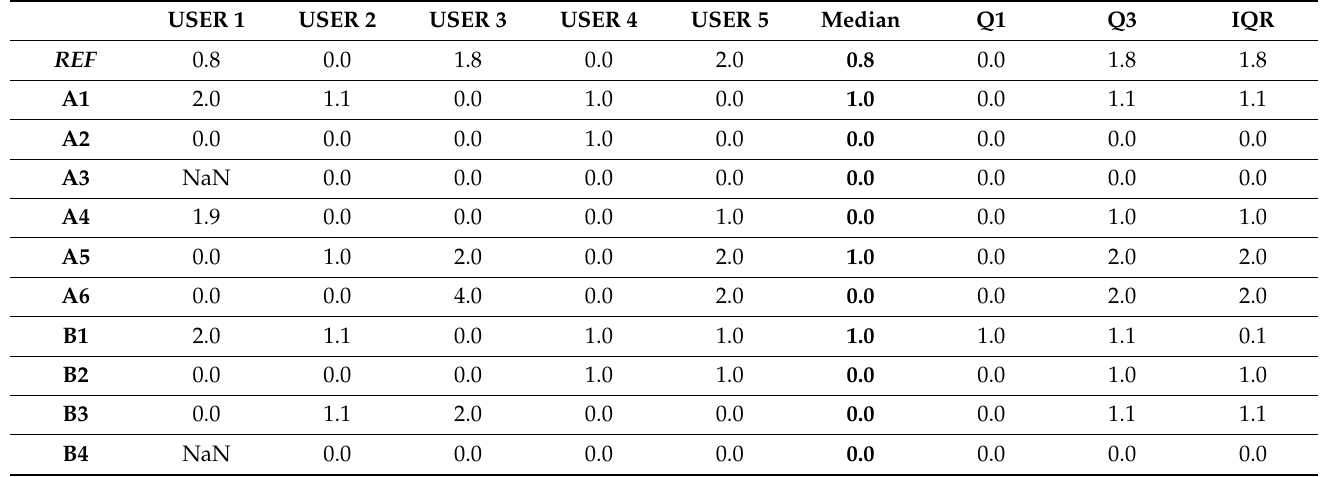
Table A6. Rhythmic asymmetry: users’ asymmetry index on